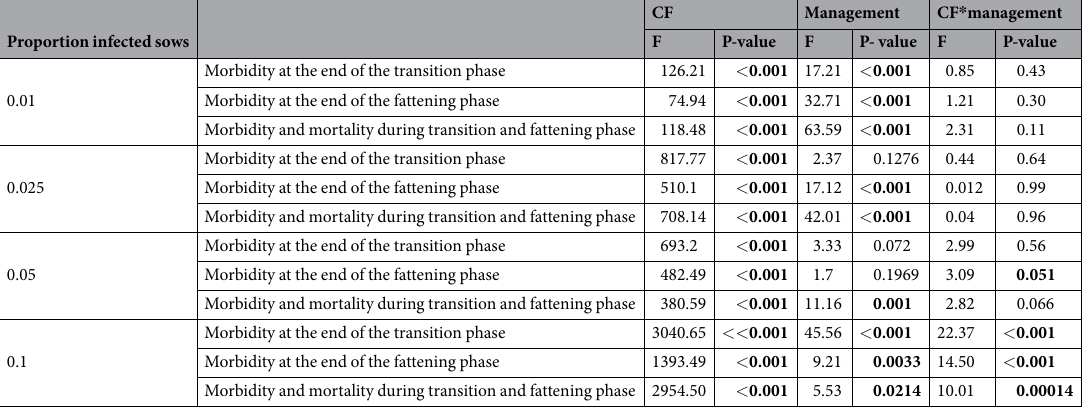
Table 2. ANOVA analysis results on the effect of management during the lactation (cross-fostering), transition and fattening period on morbidity and mortality at the end of the transition and fattening period. Morbidity is calculated as the percentage of infected animals versus the whole population during one period and mortality is calculated as the percentage of dead animals versus the whole population during one period. In bold type appear statistically significant results. CF means cross-fostering. Management refers to orderly or random movements during transition and fattening. F means the statistical contrast